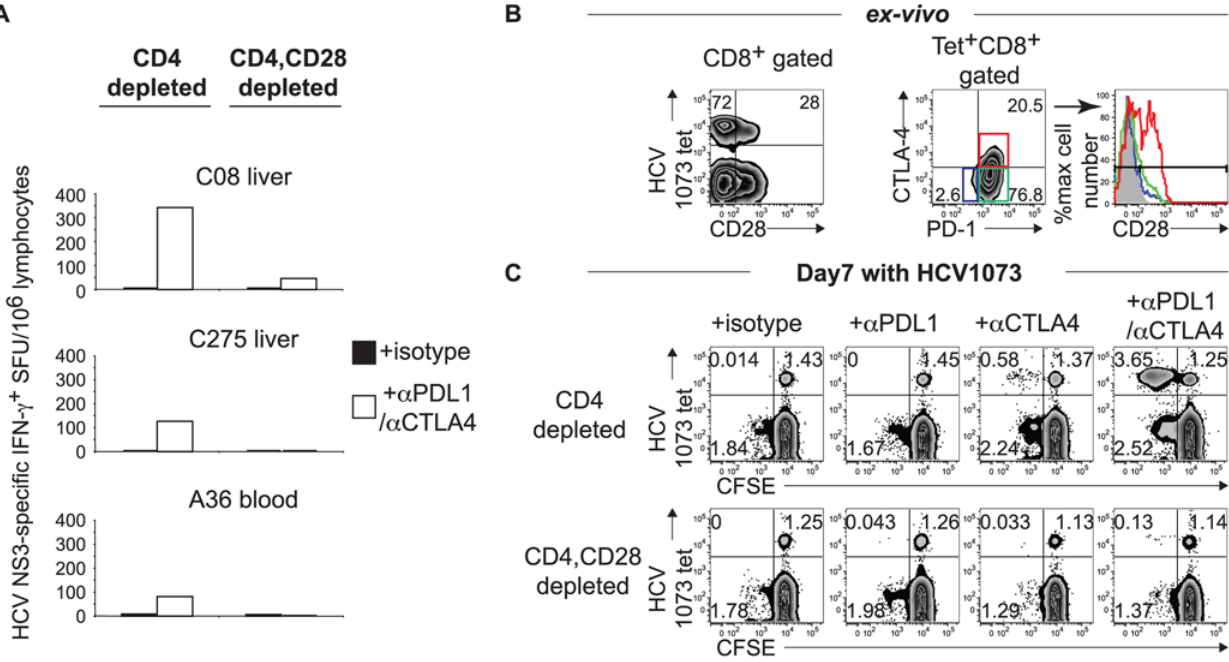
Figure 7. The functional restoration by PD-1/CTLA-4 blockade is CD28-dependent. (A) Loss of HCV-specific CD8 T-cell IFN- c response by CD28 depletion. LIL or PBL from 3 HLA-A2-negative patients with chronic (C08, C275) and acute (A36) hepatitis C were depleted of CD4 without or with additional CD28 depletion before in vitro culture for 7 days with HCV NS3-derived overlapping 15mer peptides in the presence of isotype or PD- 1/CTLA-4 blockade. Cultured cells were examined for HCV-specific IFN- c production in a 45 hour IFN- c ELISPOT assay. (B) CD28 expression in HCV- specific NS3 1073-specific tetramer + CD8 T-cells relative to PD-1 and CTLA-4 expression ex vivo . (left) Peripheral HCV 1073-specific tetramer + CD8 T cells from an HLA-A2 + acute HCV patient (A47) display CD28 expression in 28%. (middle) Gated HCV 1073-specific tetramer + CD8 T cells show the characteristic PD-1 (97.3%) and CTLA-4 (20.5%) expression. (right) Increased CD28 expression in gated PD-1 + CTLA-4 + (Red; 50.0%) HCV tetramer + CD8 T cells compared to PD-1 + CTLA-4 2 (Green; 19.5%) and PD-1 2 CTLA-4 2 (Blue; 12.2%) subsets and isotype control (gray shade) in histogram. (C) Effect of CD28-depletion on antigen-specific expansion in the presence of PD-1 and/or CTLA-4 blockade is shown by CFSE-dilution for HCV NS3 1073- specific tetramer + CD8 T cells from patient A47. CD4 depleted PBL with and without CD28-depletion were CFSE-labeled and stimulated for 7 days in vitro with HCV NS3 1073 peptide in the presence of isotype or blocking antibodies before flow cytometric analysis. Note that HCV tetramer + CD8 T cells remain detectable with CD28 depletion in the bottom